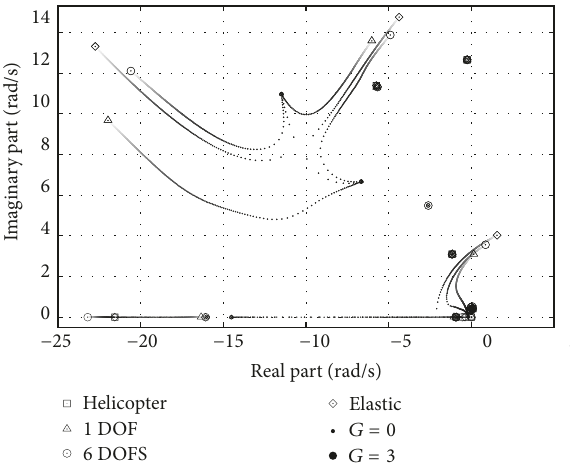
Figure 14: Transfer functions 𝑧 versus 𝜃 0 from different helicopter modeling.